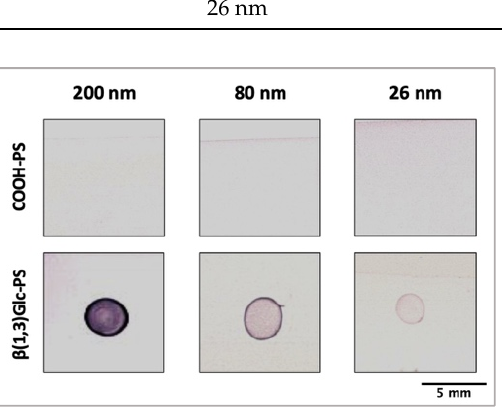
Figure 2. Analysis of ( β 1,3)-glucan onto NP surface after conjugation. Dot Blot analysis of COOH-PS and β -Glc-PS. After conjugation protocol, 0.5 mg/mL of β -Glc-PS and COOH-PS NP were spotted (5 μ L) on nitrocellulose membranes and incubated with ( β 1,3)-glucan-specific mAb.